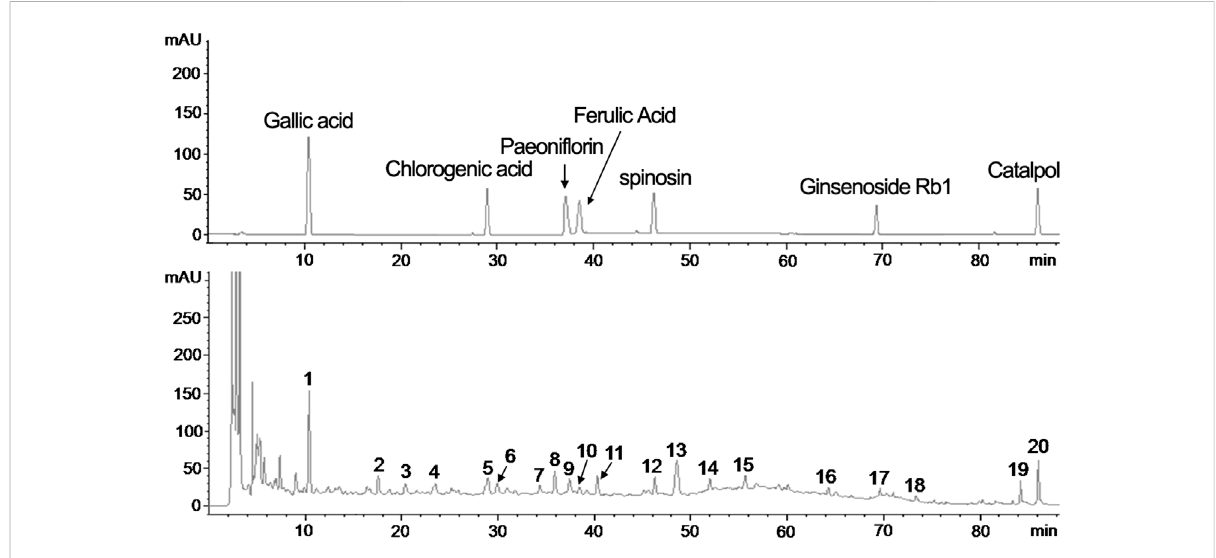
FIGURE 1 The fi ngerprint of the YXX keli by HPLC. (A) . The reference standard. (B) . The 20 characteristic peaks of the YXX keli fi ngerprint. The No. 1 peak (Gallic acid),No. 5peak (Chlorogenic acid),No.8peak(Paeoni fl orin), No.9peak(FerulicAcid),No.12 peak(Spinosin), No.17peak(GinsenosideRb1), and No. 20 peak (Catalpol) are determined compared with the reference